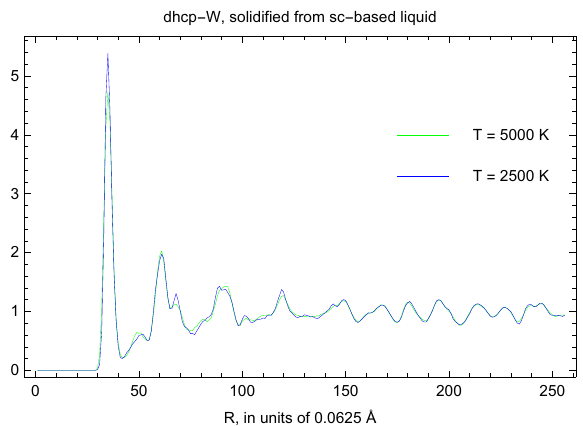
Figure 17. RDFs of the final states of the solidification of liquid W at ∼ 1200 GPa at lower